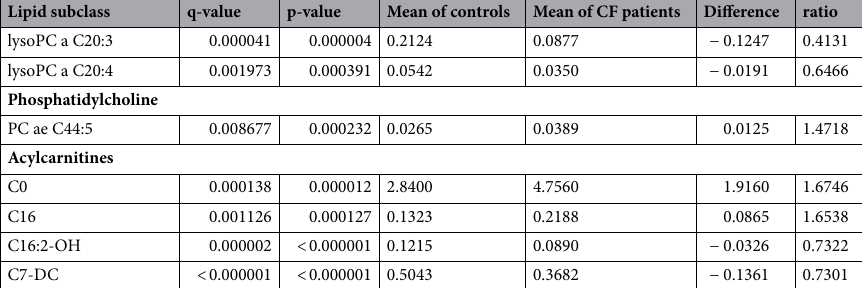
Table 2. Differentially abundant lipids (microM) in the CF saliva versus